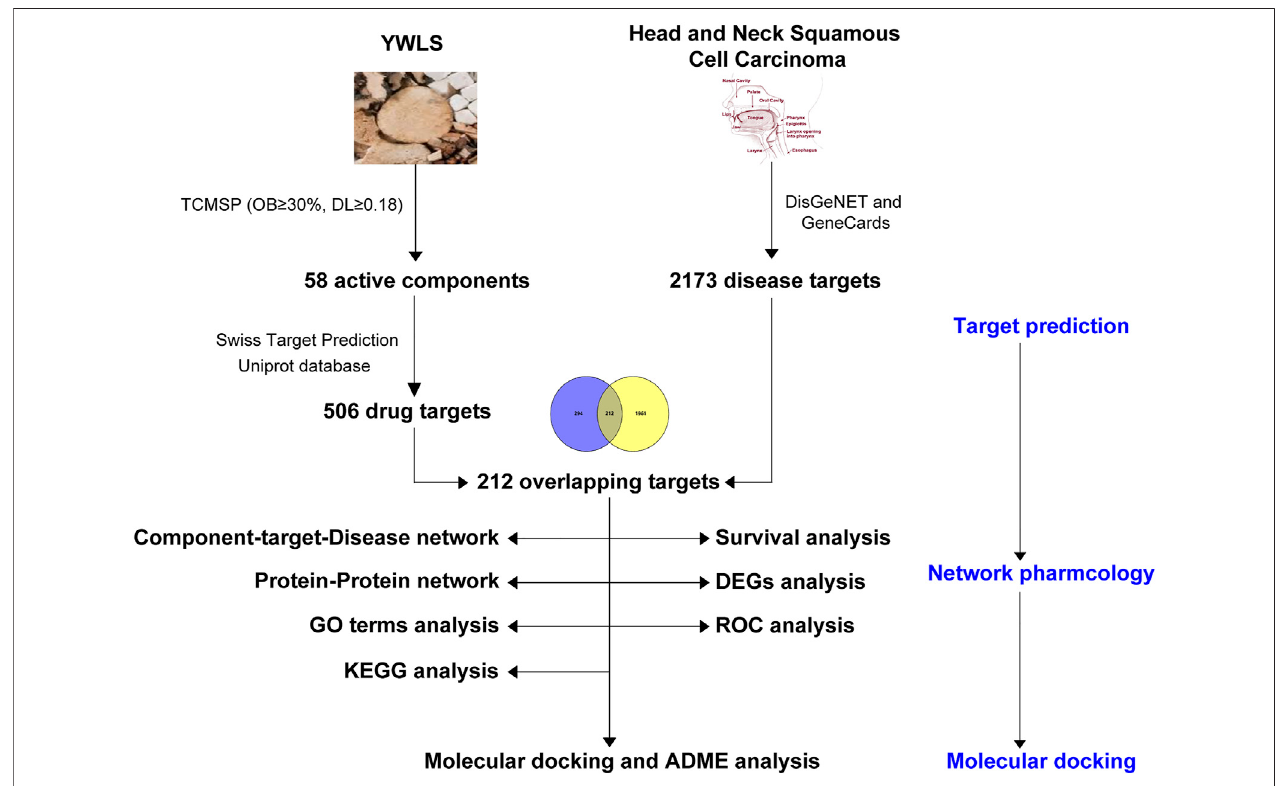
FIGURE 1 | The work fl ow of this